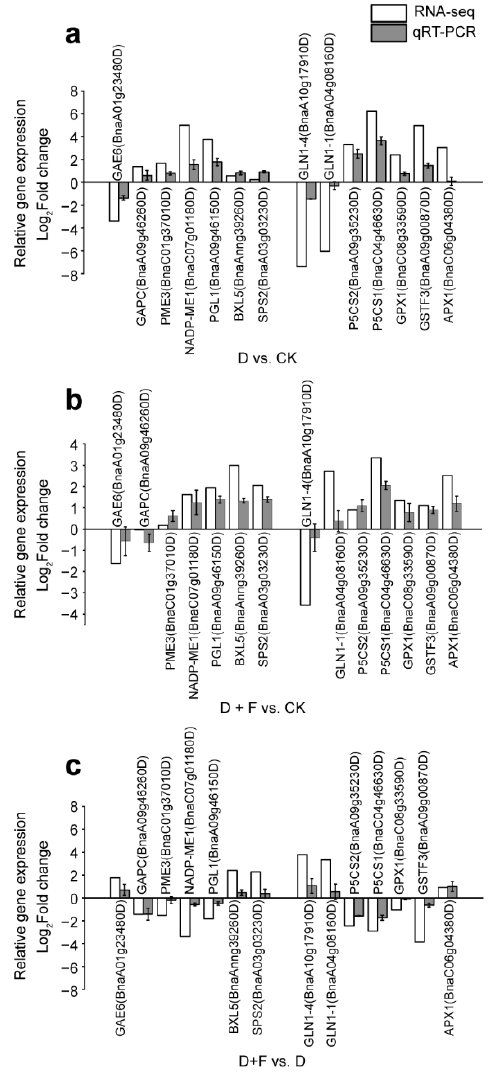
Figure 5. Validation of the expression levels of differentially expressed genes obtained from RNA-seq analyses using qRT-PCR. CK: check (sufficient water condition); D: drought; F: fullerol. ( a ) Group D vs. CK. ( b ) Group D + F vs. CK. ( c ) Group D + F vs. D. Values are the means of three replicates ± standard error.